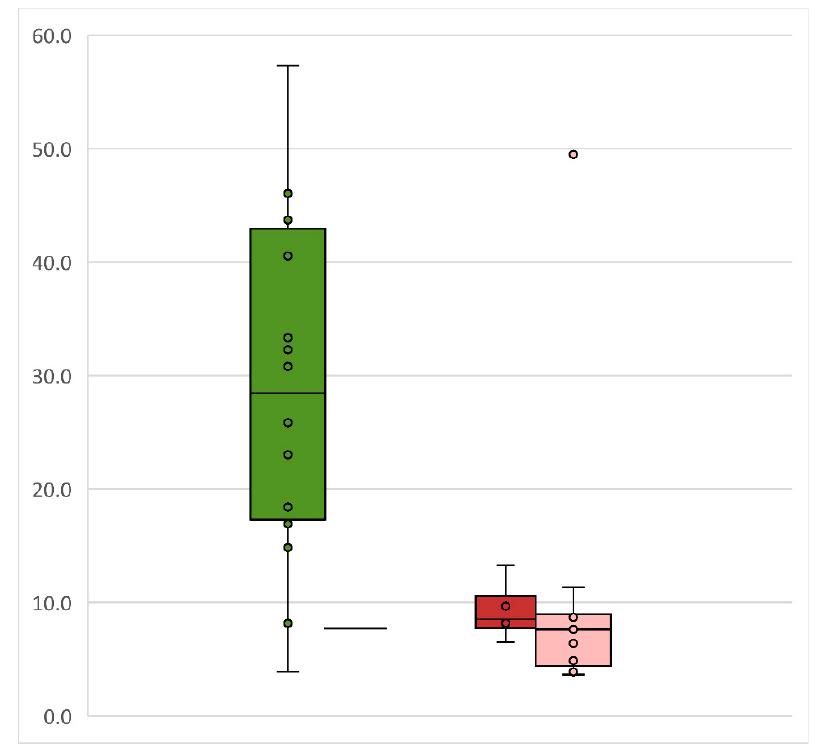
Figure 3. Total biopsy size by biopsy technique and diagnostic value. Adverse Events Table 2. Histological diagnosis of sarcoidosis by biopsy.